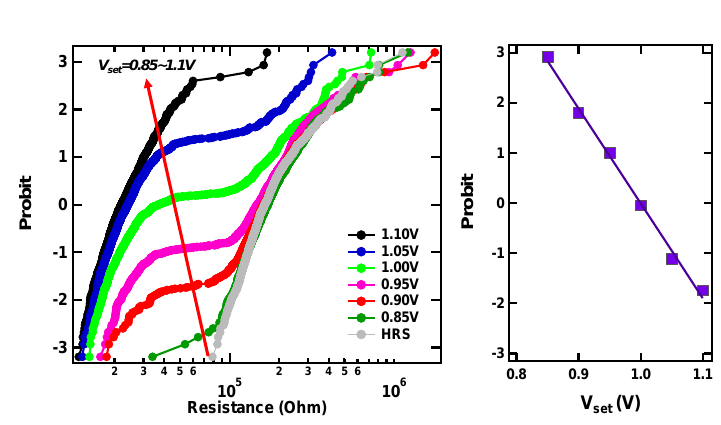
Figure 6: A simulation on the resistance distribution after SET operation for different V set . The right figure shows the set failure probability extracted from the left curves.